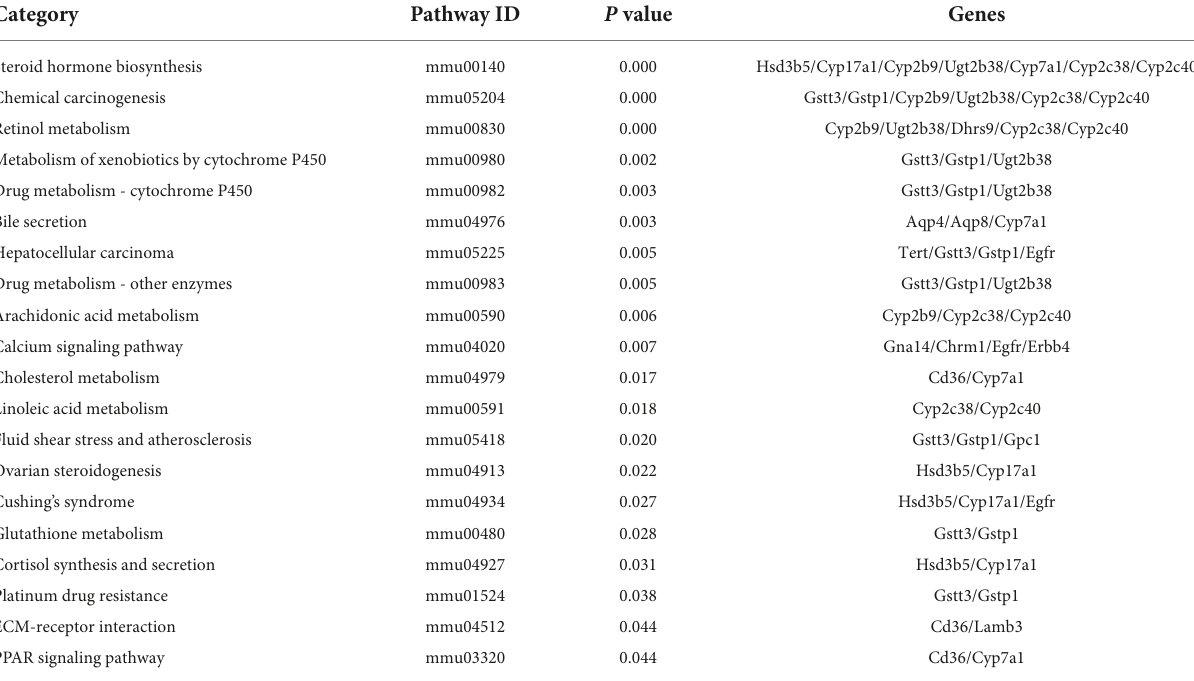
TABLE 6 Top 20 significant enriched pathways of the overlapped DEGs in